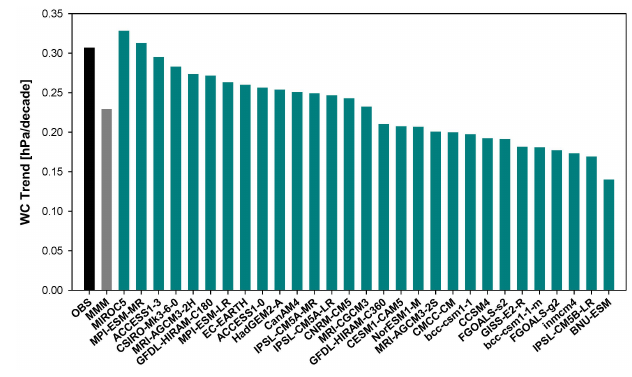
Figure 1. WC trends in the 29 models, together with those in the observations (OBS) and MMM of the 29 models. The models are arranged by the magnitude of the strengthening trend of the WC.